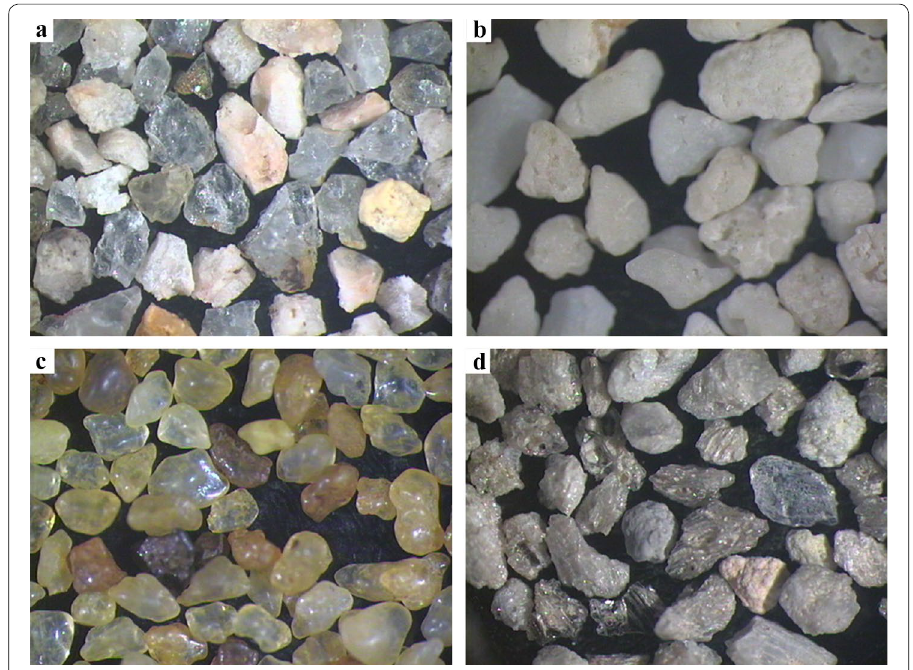
Fig. 1 Microscope images for test materials with size of 0.6–1.18 mm: a completely decomposed granite; b carbonate sand; c Leighton Buzzard sand; d pumice sand